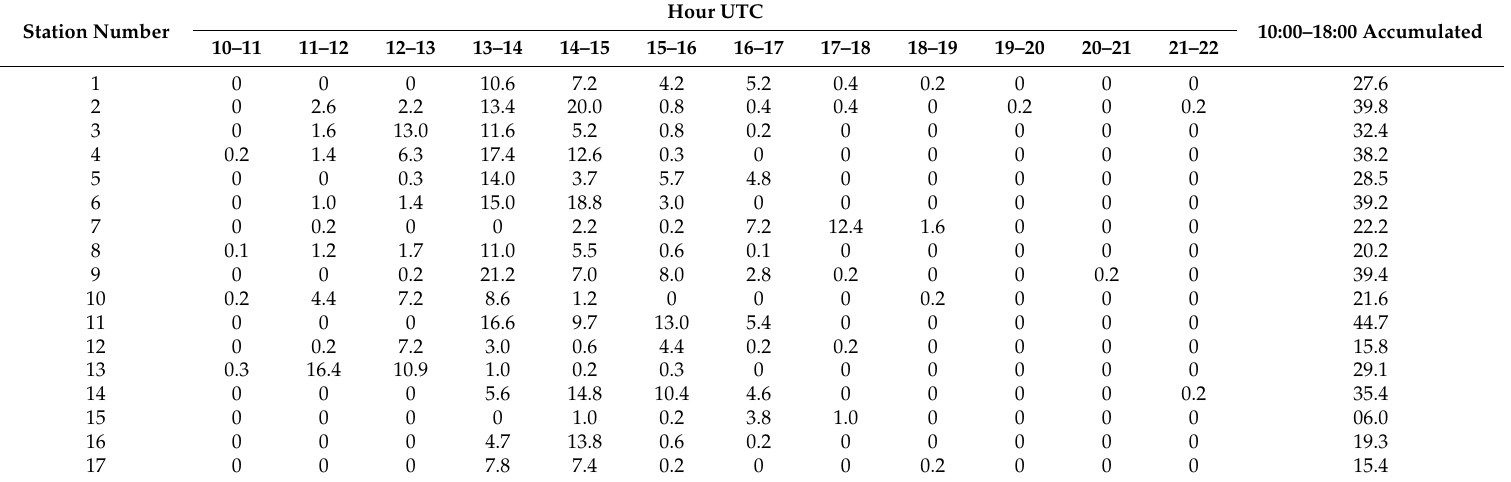
Table 3. Observed precipitation (mm) by hour and total accumulated for 7 July 2017 at stations in study